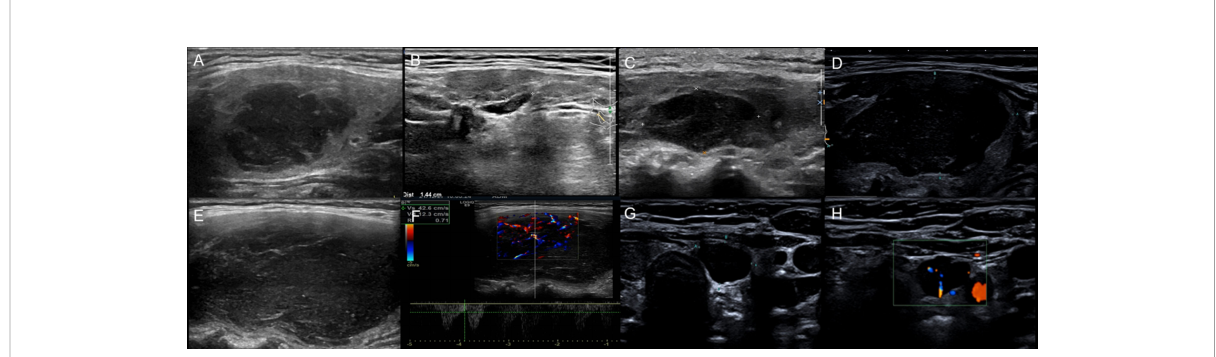
FIGURE 2 Serial US demonstrated changes in the clinical course of MALT lymphoma in a 67-year-old woman with nodular lymphoma. (A) A 3.3× 2.1 cm very hypoechoic mass of the right thyroid. (B) The mass reduced to 1.4 × 0.4 cm without treatment after 3 months. (C) After 2 years and 5 months, a 2.2 × 1.4 cm mass of the left thyroid was found. (D) Six months later, the mass of the left thyroid had obviously enlarged to 4.7×2.2 cm with very low internal echogenicity, and the diagnostician at the time thought it was a cystic nodule with hemorrhage. (E) After another 2 months, the mass enlarged to 5.0 × 2.8 cm, and the lymph nodes also enlarged. (F) One month later, the mass had grown up to 6.0 cm and was rich in blood fl ow with an RI of 0.7. (G) Another “ cystic ” nodule with enhanced posterior echo. (H) The “ cystic ” nodule had a central blood fl ow and was diagnosed as a solid